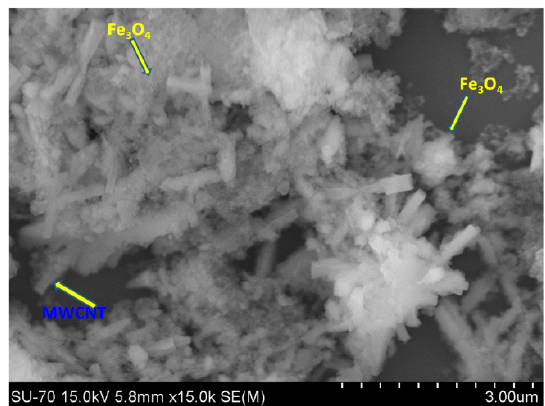
Figure 3. SEM image synthesis MWCNT + Fe 3 O 4 hybrid nanoparticles.